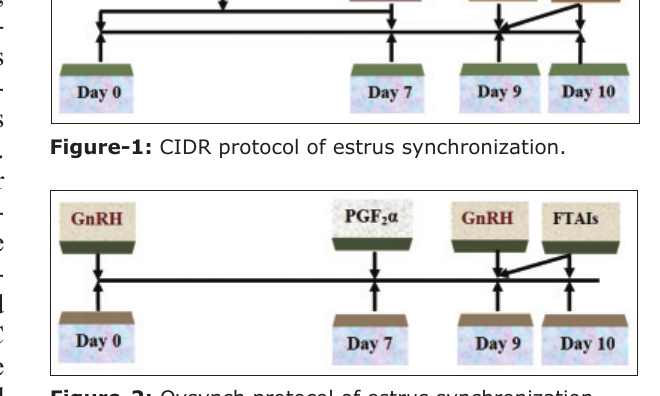
Figure-2: Ovsynch protocol of estrus synchronization.